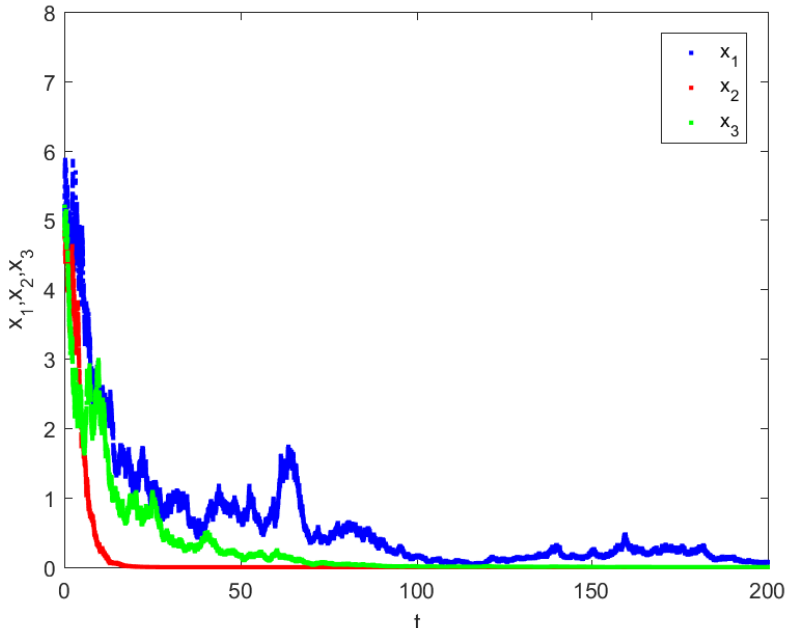
Figure 2. The extinct behavior of the solutions to the Hantavirus infection system